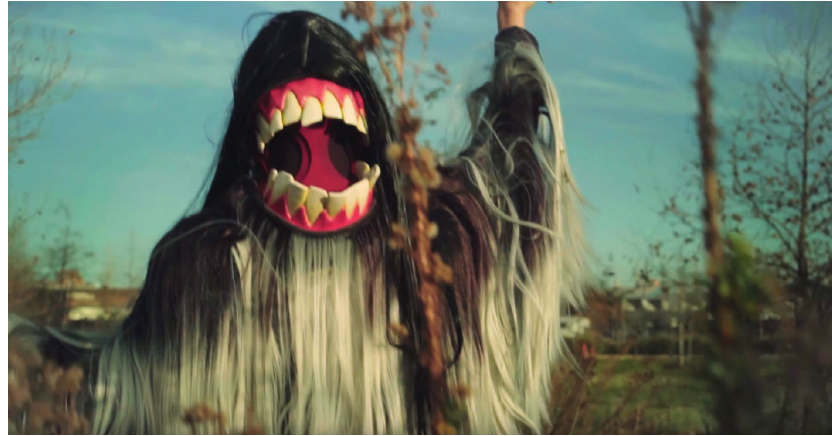
Fig. 1 Sharon Chohi Kim as Wiindigo. Still frame from the video trailer of Sweet Land by The